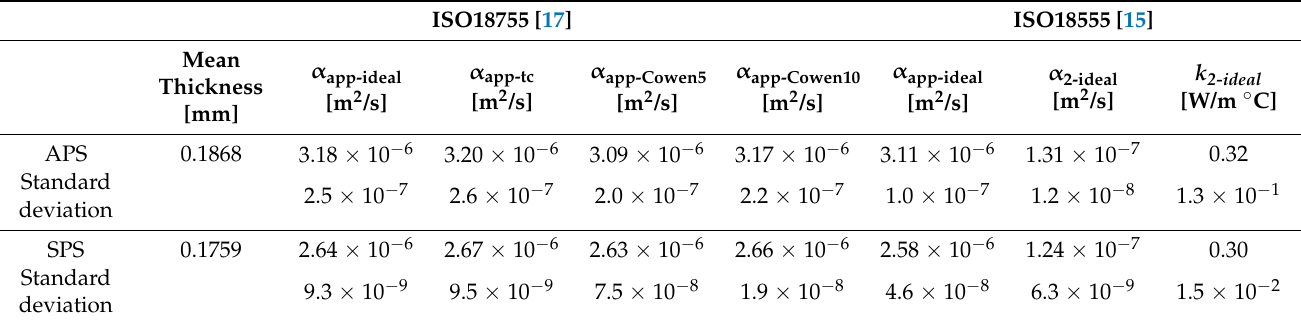
Table 4. APS and SPS: thermal diffusivity and thermal